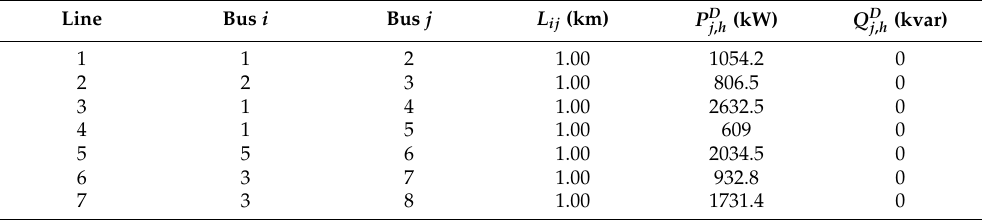
Table 5. Connection of lines and load levels of the system for the balanced case in the 8-bus test system.